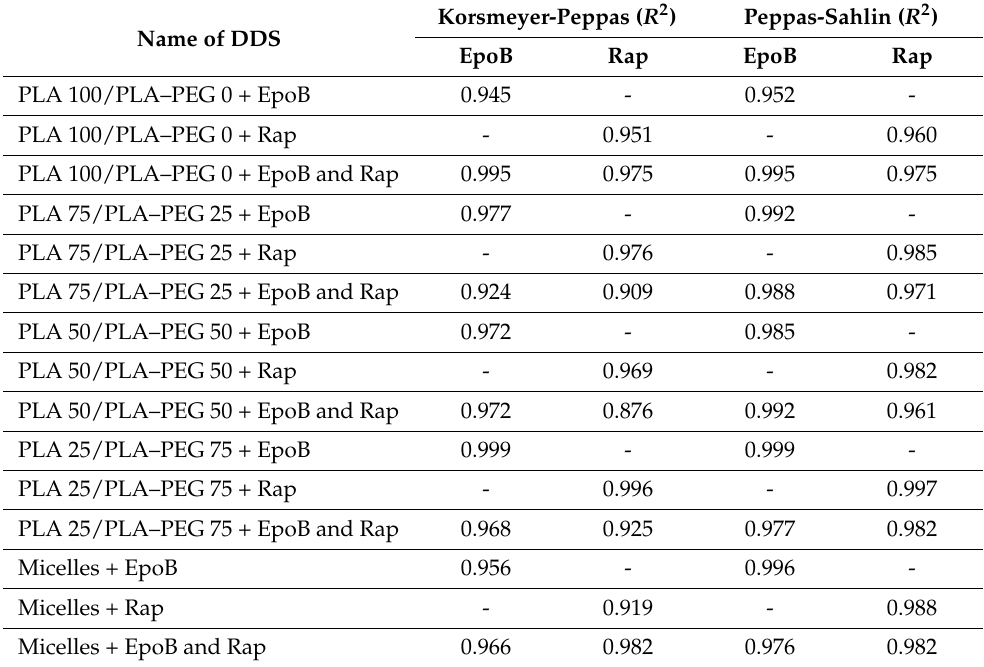
Table 3. Comparison of the regression coefficients ( R 2 ) obtained after fitting the drug release data to the Korsmeyer–Pep- pas and Peppas–Sahlin model.